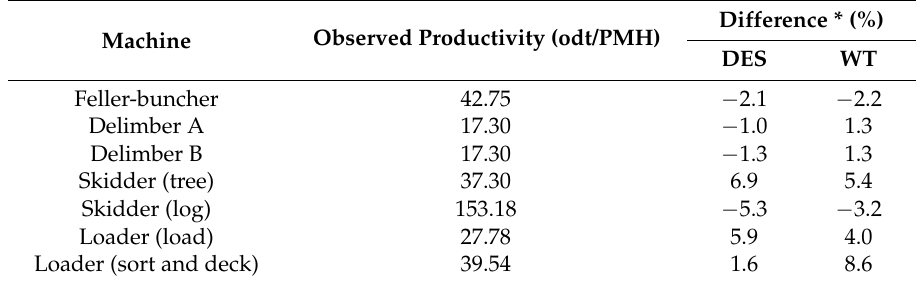
Table 7. Comparison of the estimated mean machine productivities obtained from the WT DES and TS models with the field-observed productivities for whole-tree